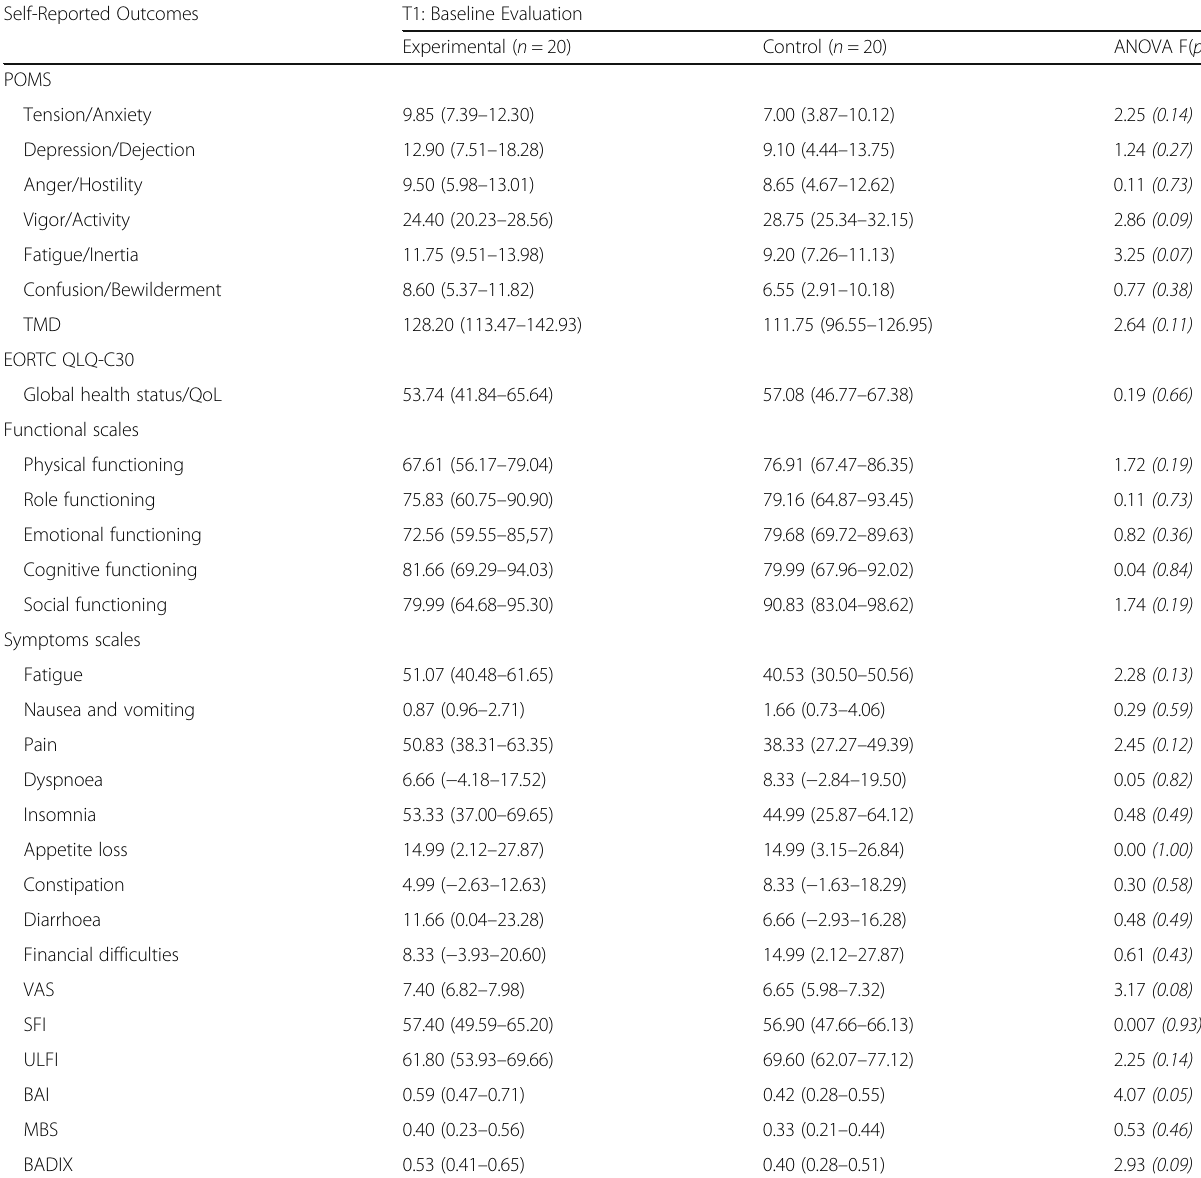
Table 2 Mean (CI 95%) and analysis of variance (ANOVA) of baseline, Patient-Reported Outcomes Self-Reported